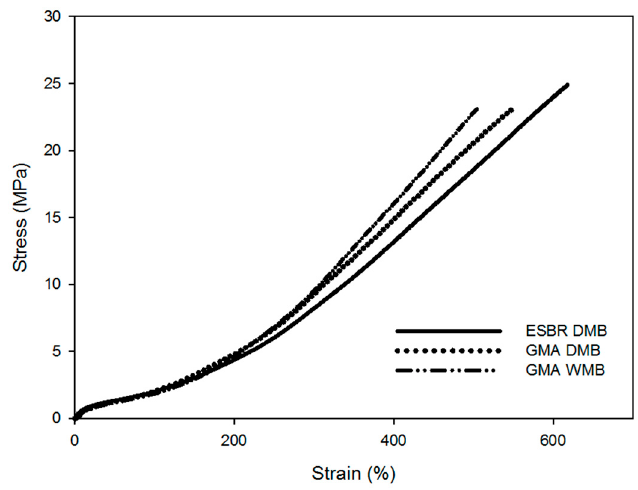
Figure 5. Mechanical properties of ESBR and GMA-ESBR vulcanizates. Table 8. Mechanical and abrasion properties of ESBR and GMA-ESBR